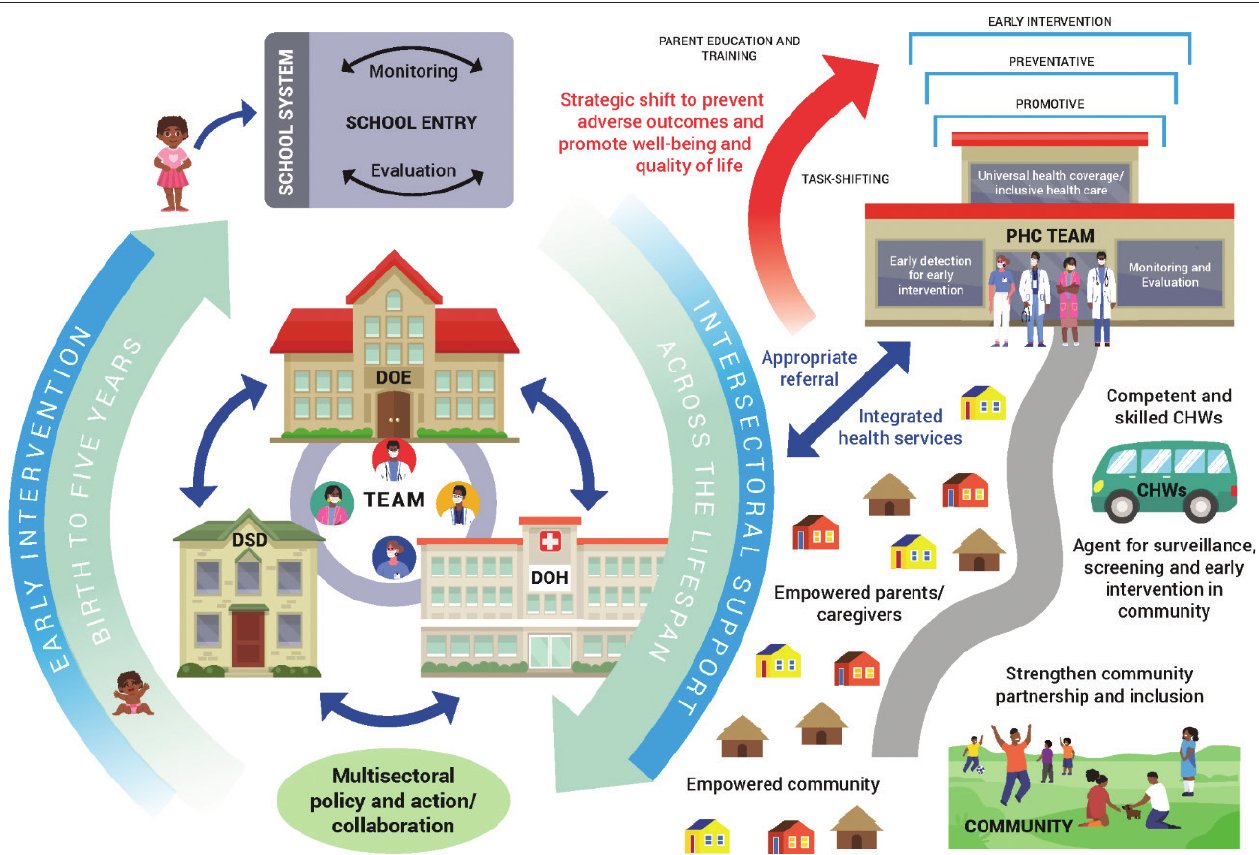
FIGURE 1 : Context of service provision in a low-resourced context of South